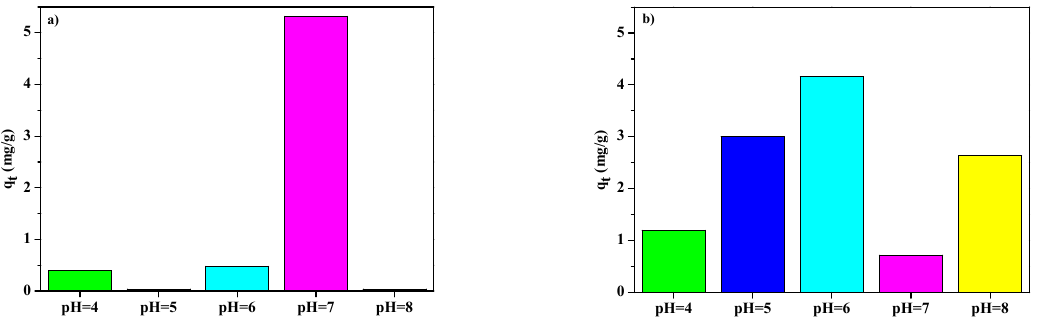
Figure 7. pH dependence of phenol sorption capacity on ( a ) NaP1, ( b ) NaP1CS.